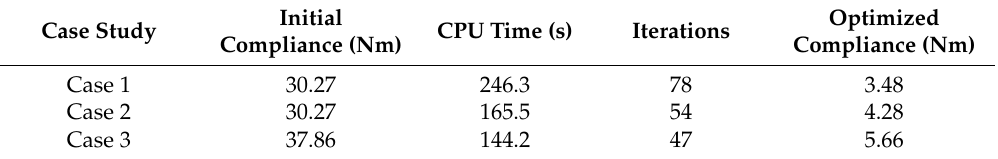
Table 4. Topology result comparisons between Case 1, Case 2, and Case